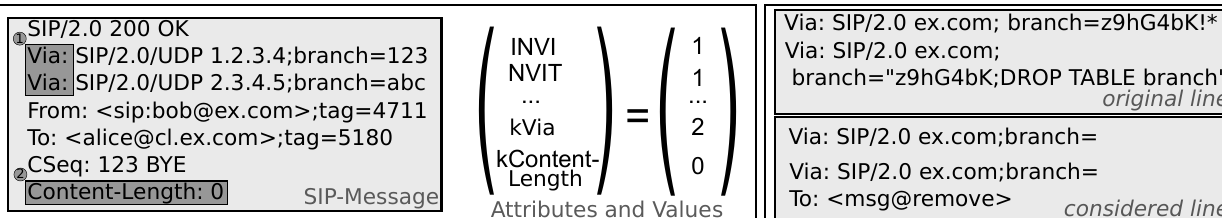
Figure 2. Examples illustrating the keyword